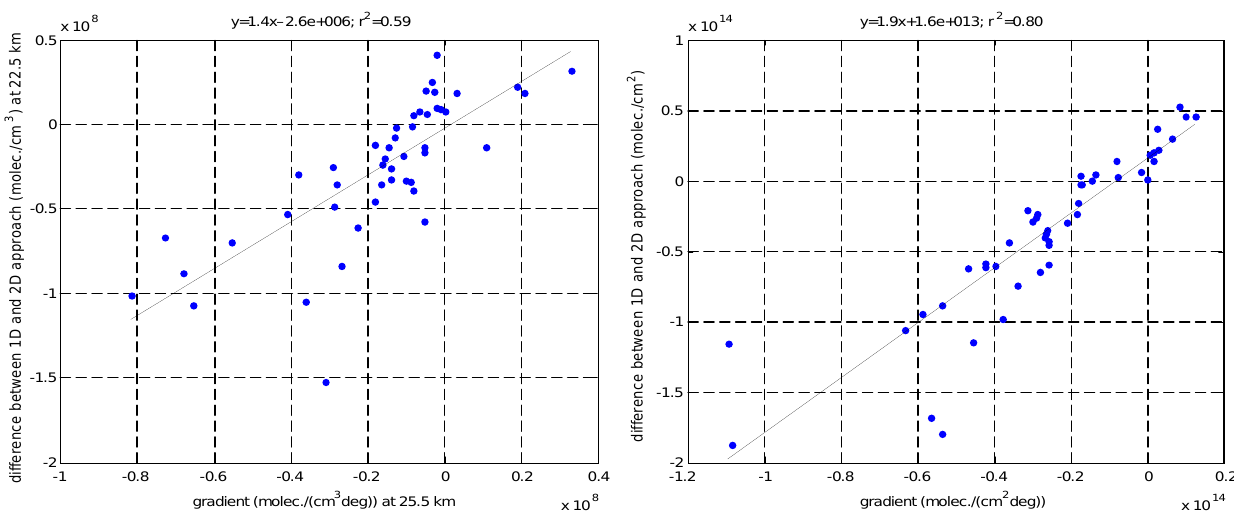
Fig. 17. Left panel: difference between the number density retrieved by the 1-D approach and the true data at 22.5km as function of horizontal gradient in the number density at 25.5km for 15 December 2007. Right panel: same, but for the stratospheric column between 15 and 39km. Also shown is the line of the best fit to the observed differences. Equations for the lines of the best fit and squared correlation coefficients r 2 are provided in the titles.